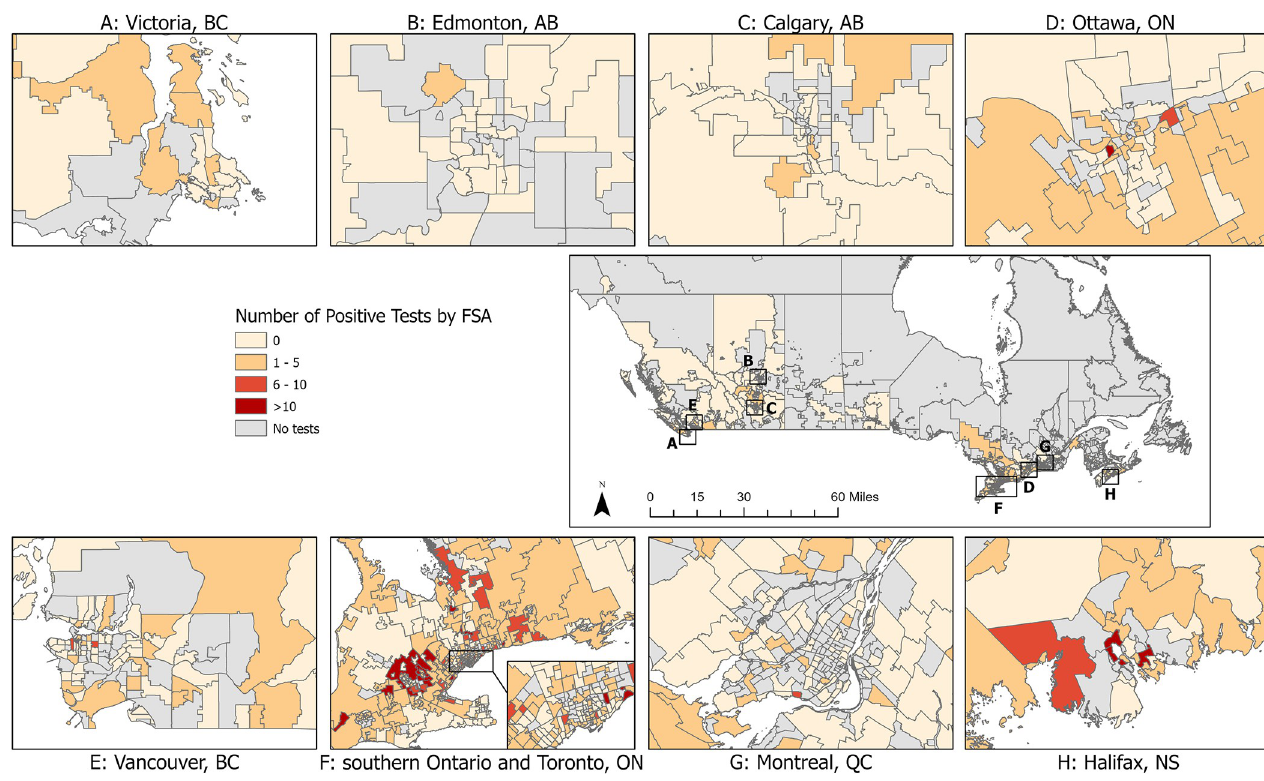
Fig 3. Number of positive canine Leptospira PCR tests by forward sorting area (FSA) in Canada, 2009–2018. FSA for submitting veterinary location.